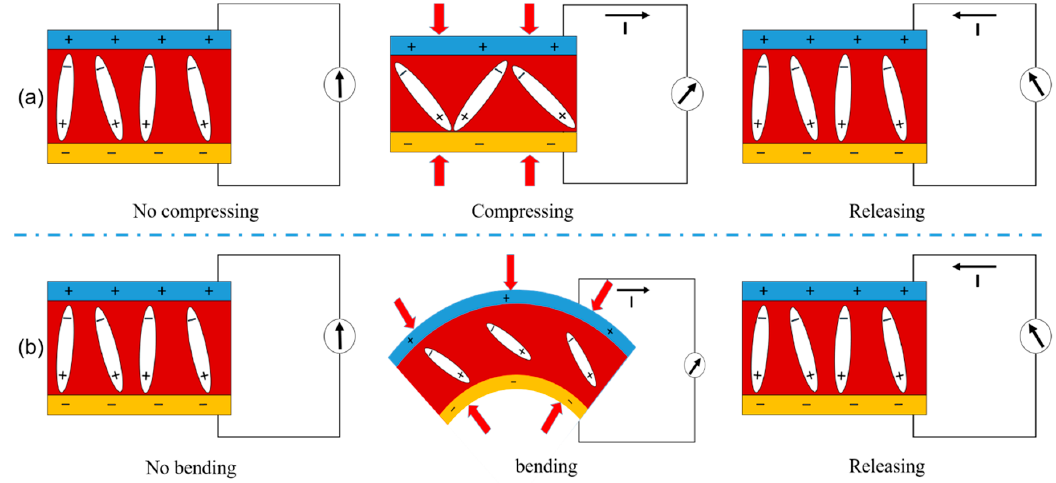
Figure 4. Schematic diagrams of the piezoelectricity of the solution-blow-spinning PVDF nanofibers. ( a ) Principles of piezoelectric output in compressing / releasing mode of PVDF fibers. ( b ) Principles of piezoelectric output in bending / releasing mode of PVDF nanofiber.